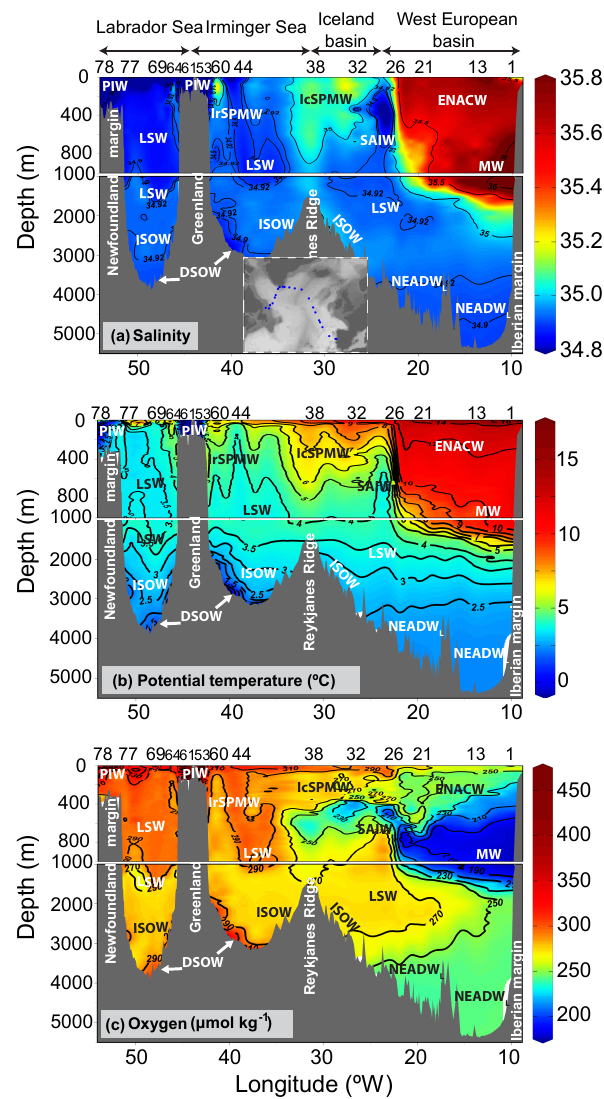
Figure 2. Vertical distribution of (a) salinity, (b) potential tempera- ture and (c) dissolved oxygen along the GEOVIDE section in spring 2014. Water mass acronyms are defined in the